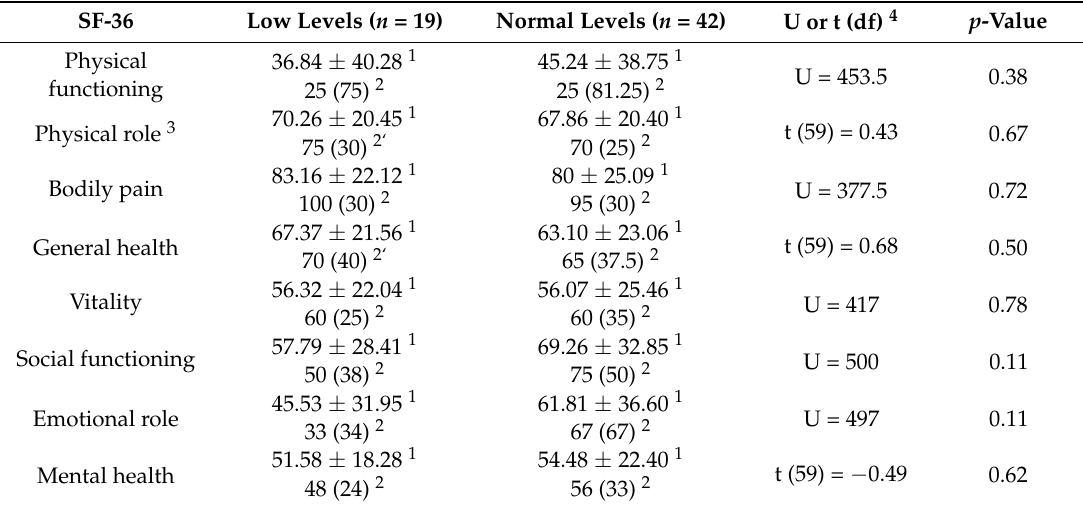
Table 11. Effects of hemoglobin levels on the SF-36 subscales.